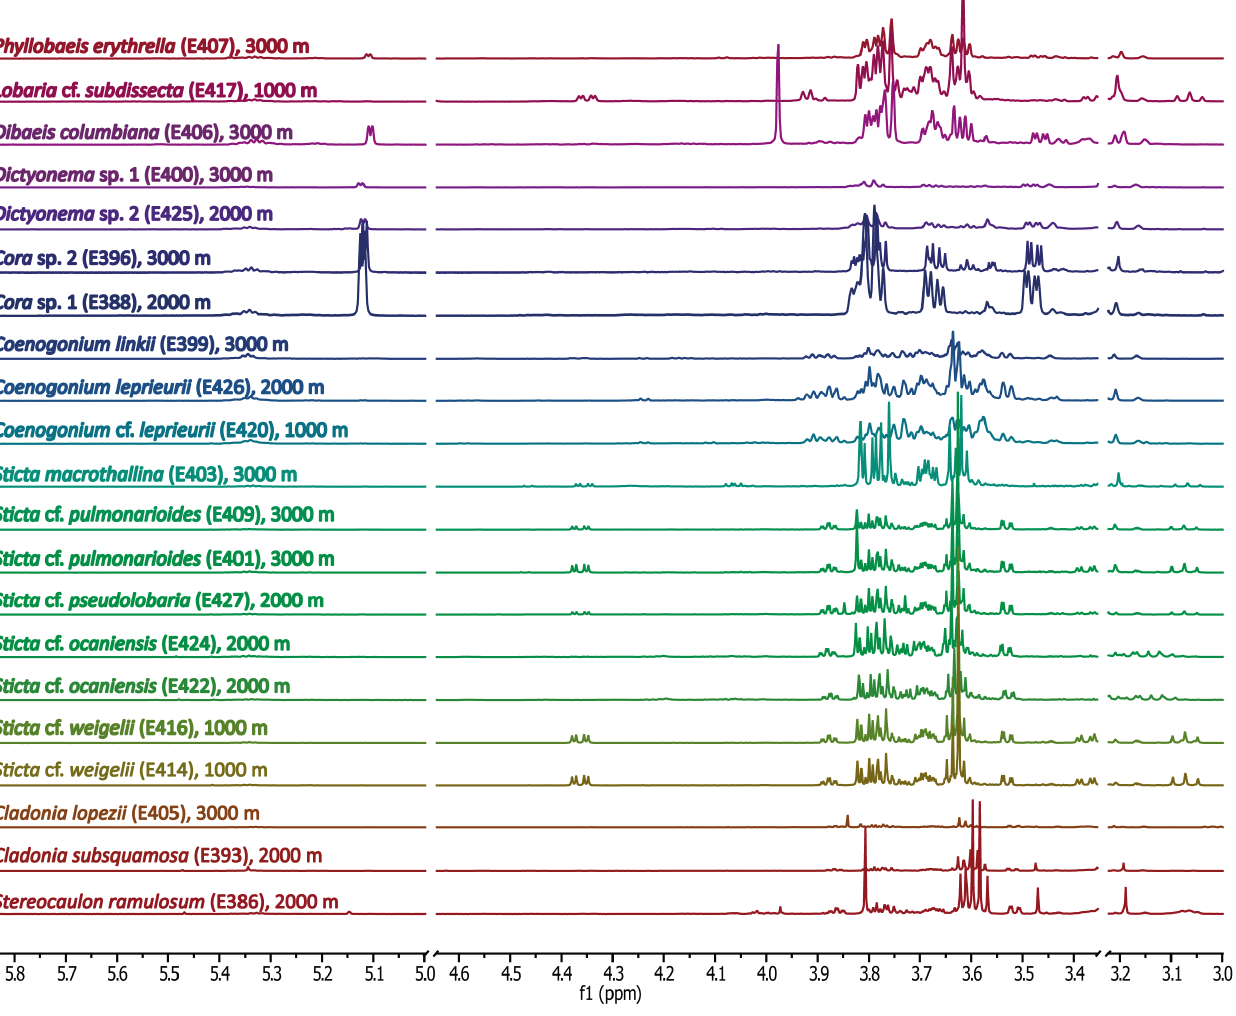
Figure 2. 1 H-NMR spectra of methanolic lichen extracts between 3.0 and 5.8 ppm. The residual signals of water ( δ = 4.8 ppm) and the solvent ( δ = 3.3 ppm) are not shown. Spectra were scaled to the intensity of the residual methyl signal of the MeOD